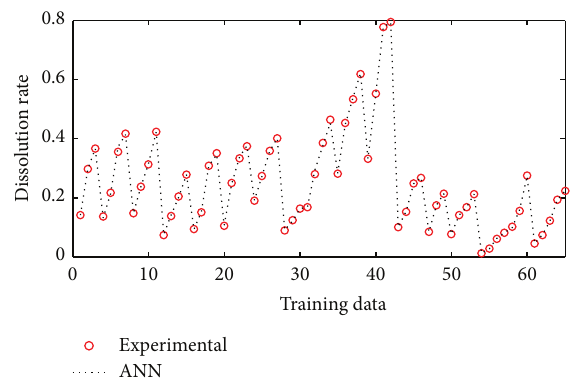
Figure 5: Comparison of ANN and experimental results for the training results.